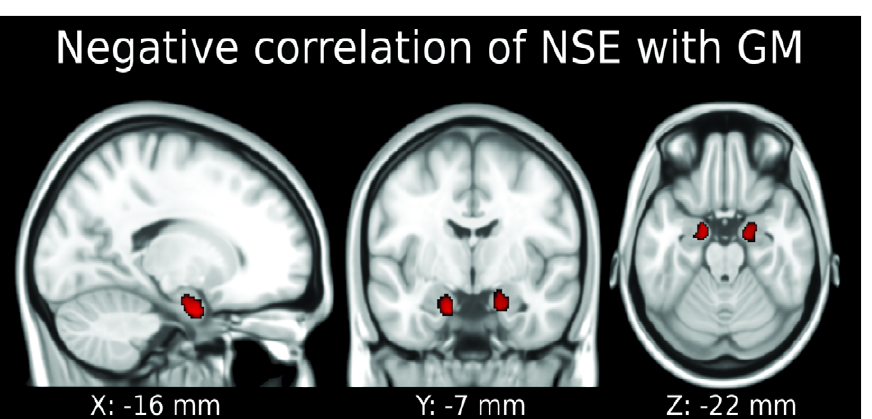
Figure 2. Gray matter density (GM) in both amygdalae and both most anterior hippocampi is correlated with serum neuron-specific enolase (NSE) in the female brain. No significant results were obtained for male subjects. p , 0.05 family wise error was applied, reported coordinates are MNI coordinates. Neurological convention (left side of the brain is presented on the left).